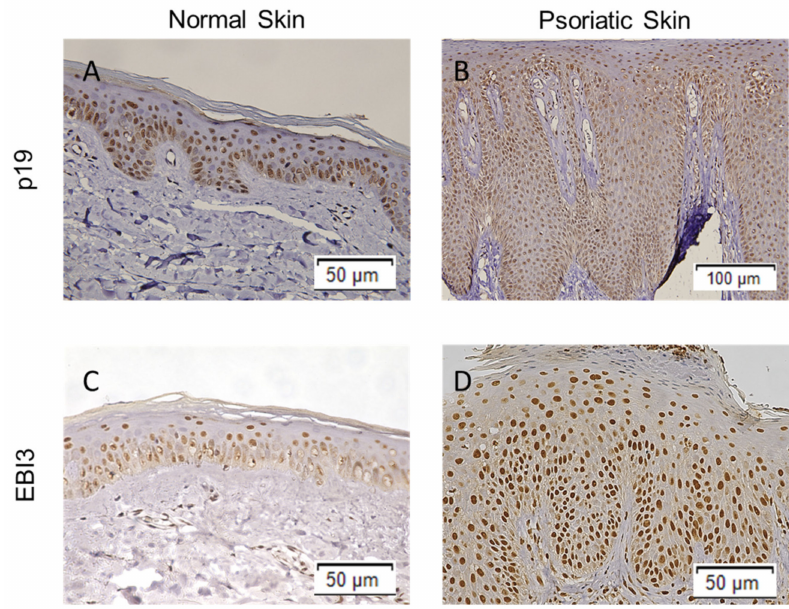
Figure 1. Expressions of IL-23Ap19 and EBI3 are upregulated in psoriatic keratinocytes. Expressions of IL-23Ap19 and EBI3 were examined in normal skin and lesional psoriatic skin sections by immuno- histochemistry with polyclonal rabbit anti-IL-23p19 antibody ( A , B ) and monoclonal mouse anti-EBI3 antibody ( C , D